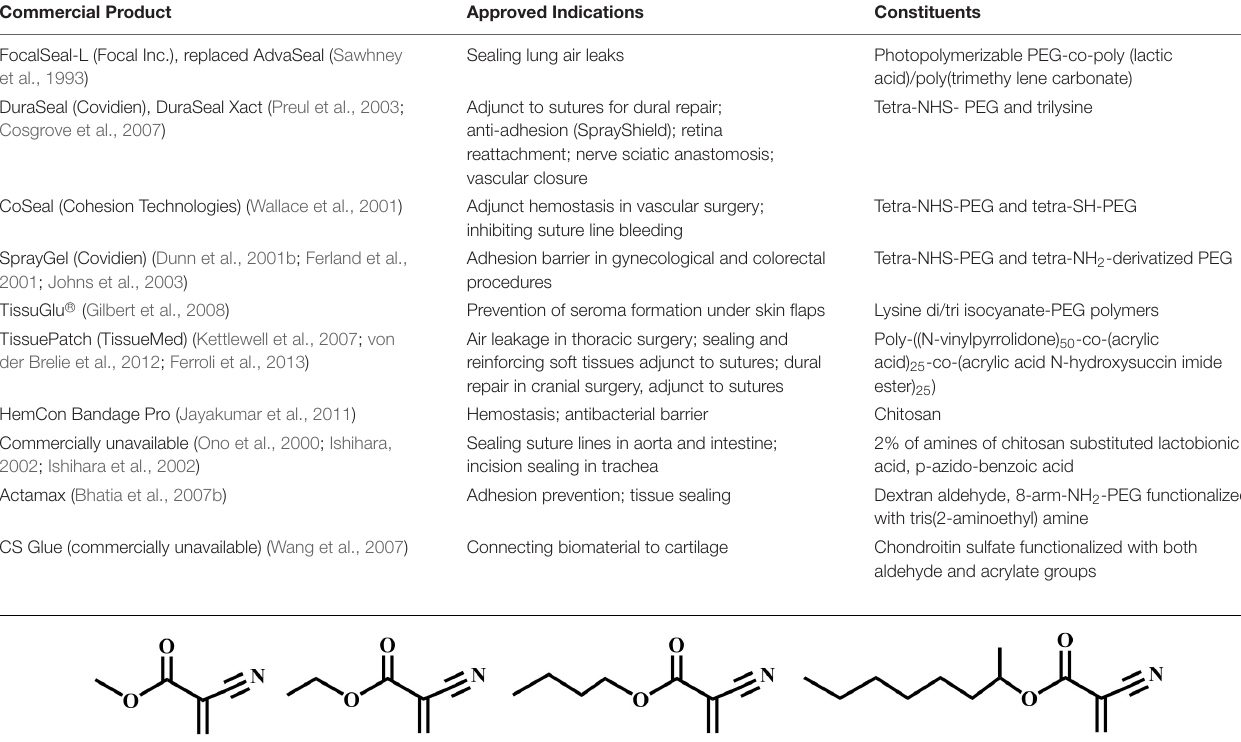
TABLE 1 | Commercially available synthetic polymer and polysaccharide-based tissue adhesives.